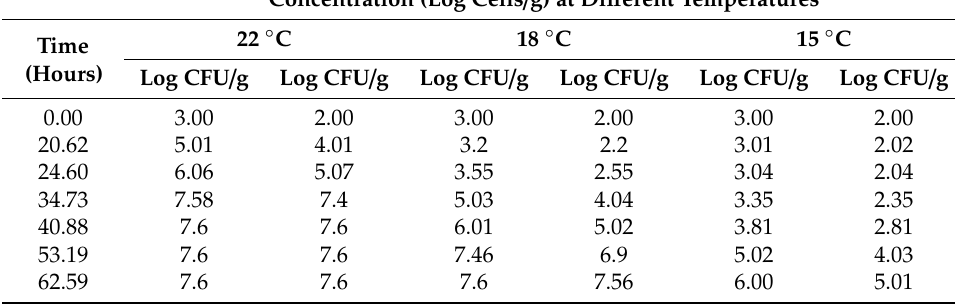
Table 3. Rate of growth of B. cereus from initial contamination levels of 2 log CFU / g and 3 log CFU / g in water bu ff alo mozzarella cheese (pH 5.7 and a w 0.997) at three temperatures (15, 18 and 22 ◦ C) calculated by ComBase Predictor software (www.combase.cc).